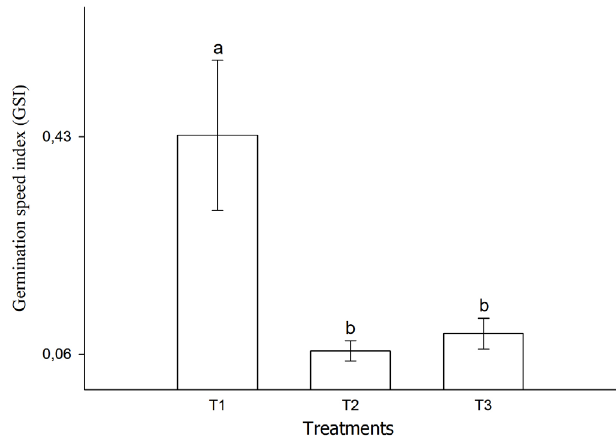
Fig 1. Germination speed index of T1, T2, and T3 treatments, where T1: seeds cleaned by ants (free of the pericarp, without pulp, and endocarp); T2: aryl-free seeds, cleaned manually; and T3: seeds with aryl. Means followed by the same letters between columns do not differ from each other based on the Tukey’s test at